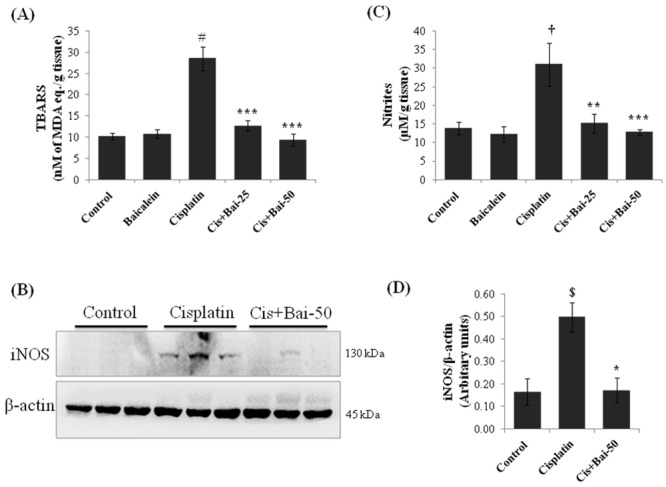
Effect of baicalein on cisplatin-induced renal lipid peroxidation and nitrative stress.(A) Thiobarbituric acid reactive substances (TBARS), as a marker for lipid peroxidation, (B) Immunoblot of iNOS and (C) tissue nitrate levels, as markers for nitrative stress. Immunoblot was representative of three independent experiments. β-actin was used as internal control. Bar diagram showing densitometric analysis for relative expression of (D) iNOS and values are the means ± SEM (n = 3). For the estimation of TBARS and nitrites, the data were expressed as the means ± SEM of 8 animals. Where iNOS, inducible nitric oxide synthase; MDA, malondialdehyde. $p< 0.05, †p< 0.01 and #p< 0.001 vs. vehicle control group, *p< 0.05, **p< 0.01 and ***p< 0.001 vs. cisplatin control group.